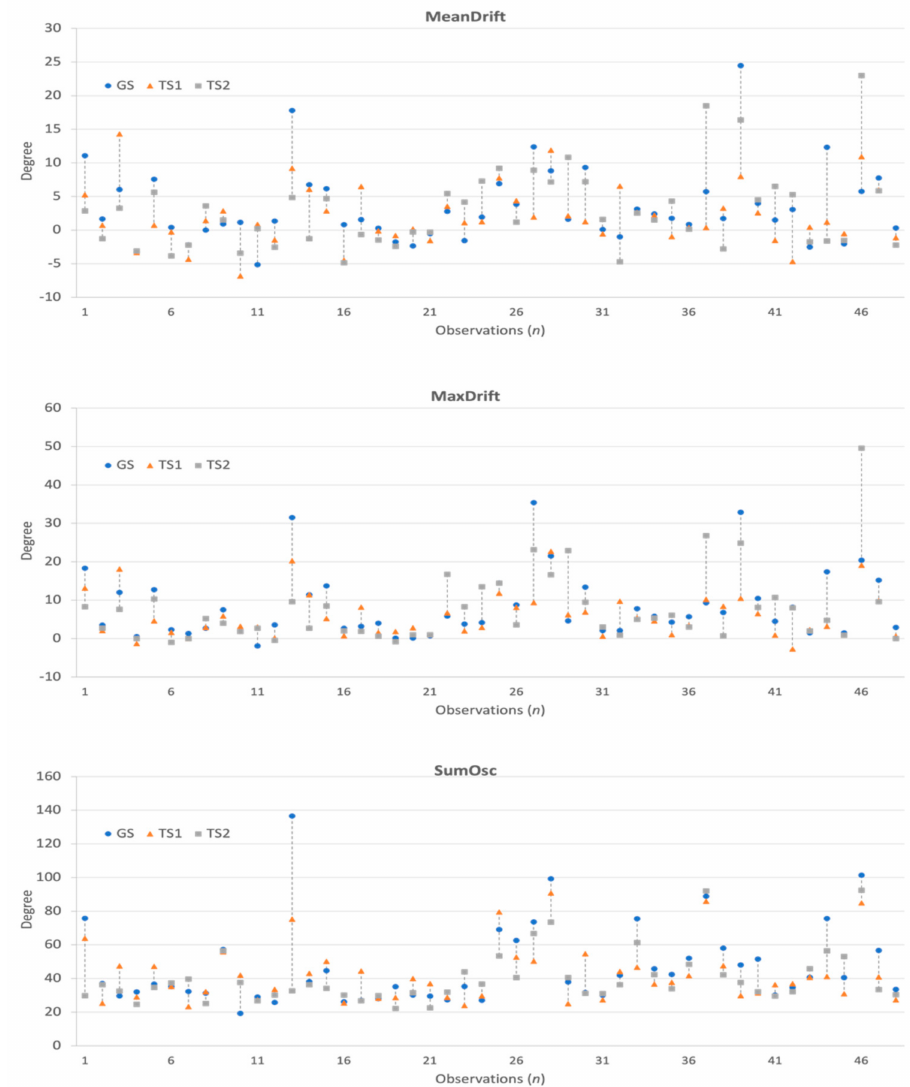
Figure 4. Kinematic features and differences observed in GS, TS1, and